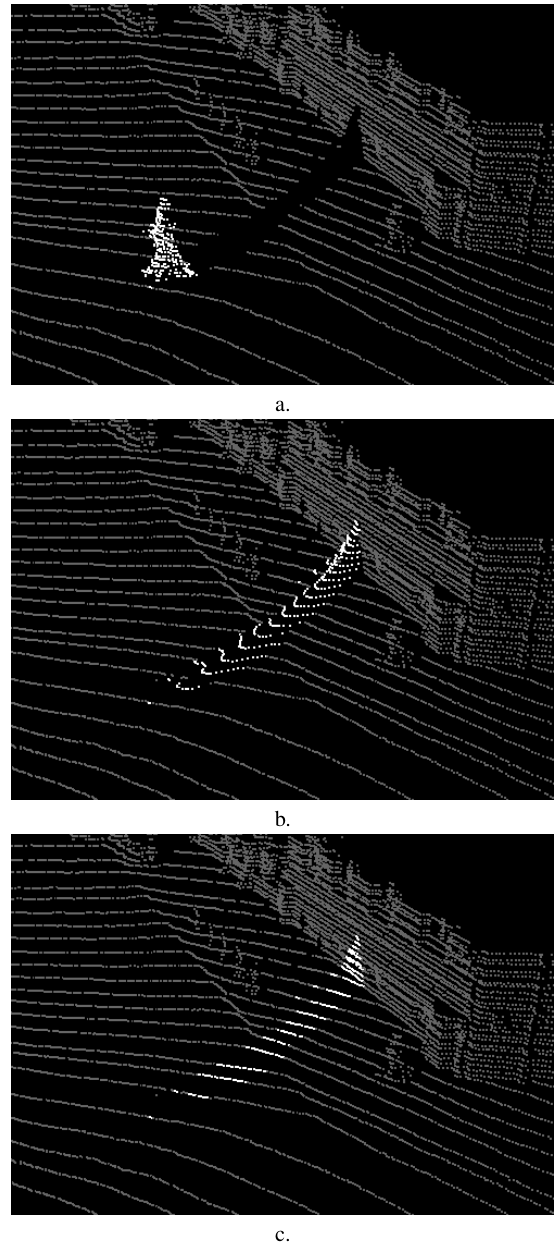
Figure 7. Comparison between disocclusion algorithms. (a) is the original point cloud (white points belong to the object to be disoccluded), (b) the result after Gaussian diffusion and (c) the result with our proposed